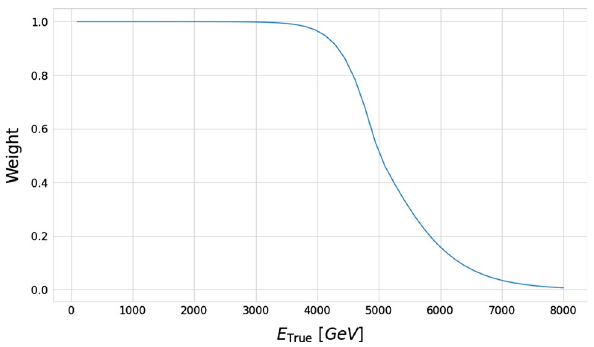
Fig. 6 Data weight as a function of true muon